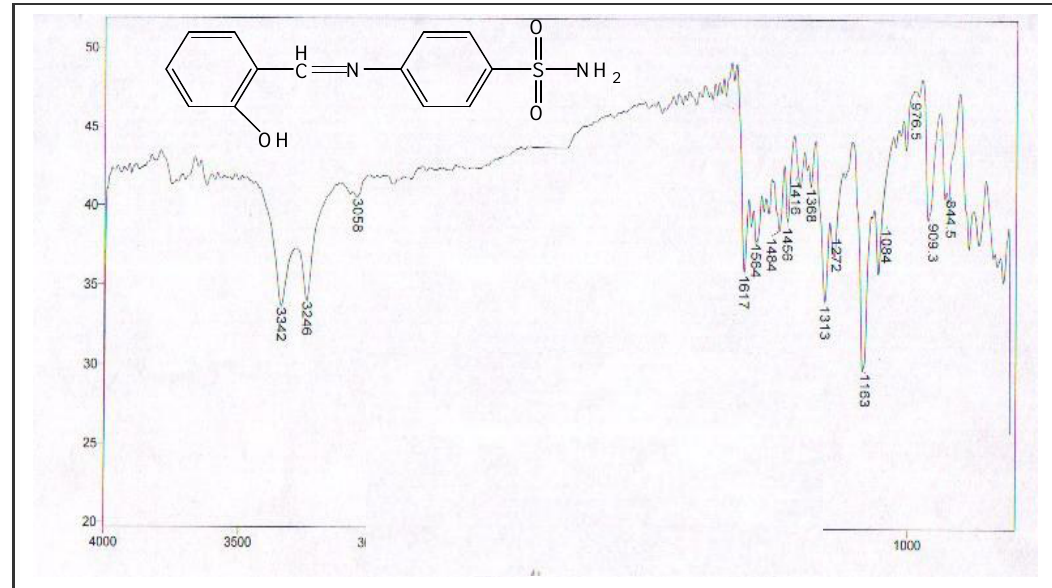
IR spectrum of compound 2 in KBr